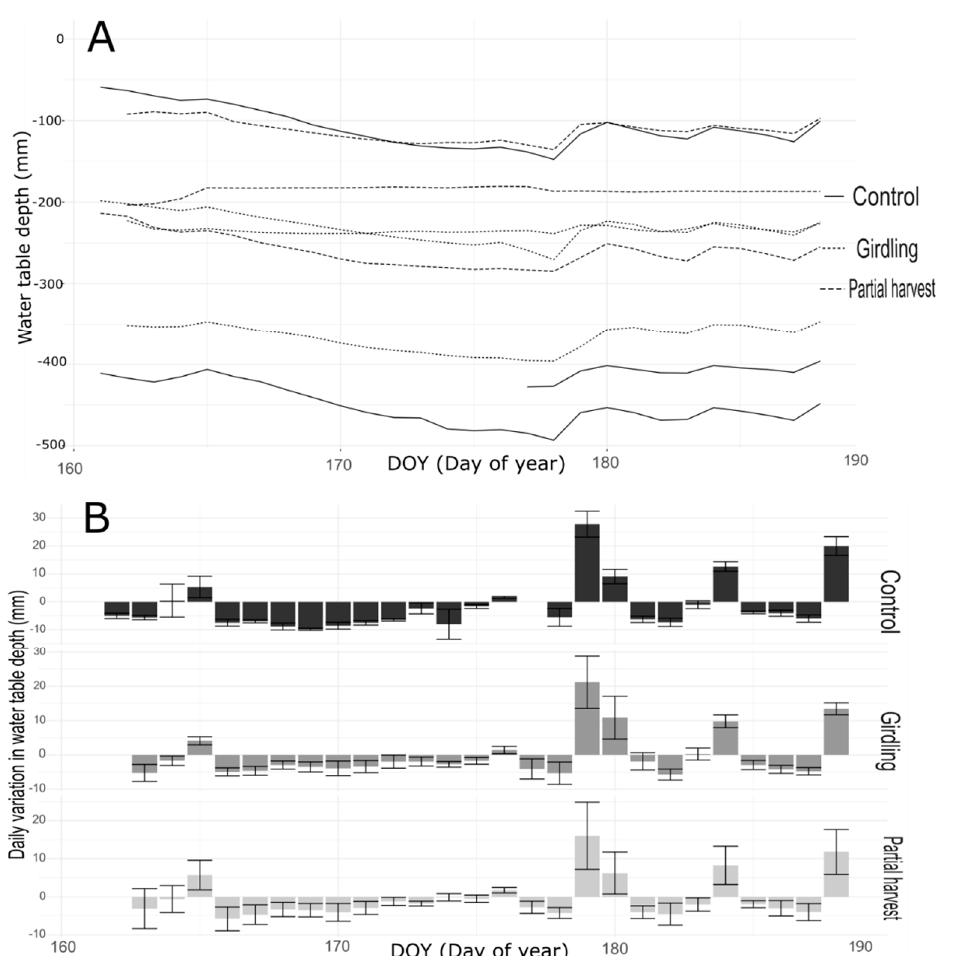
Figure 2. Water table movement throughout the growing seasons of 2016, before the sylvicultural treatments. ( A ) water table depth of each plot according to treatment. ( B ) Mean daily variation in water table depth ( ∆ WT) with standard error (mean ± SE) Each daily variation in water depth is a mean based on water table depth of three different plots for each treatment. The missing data for the water table depth are due to technical problems.